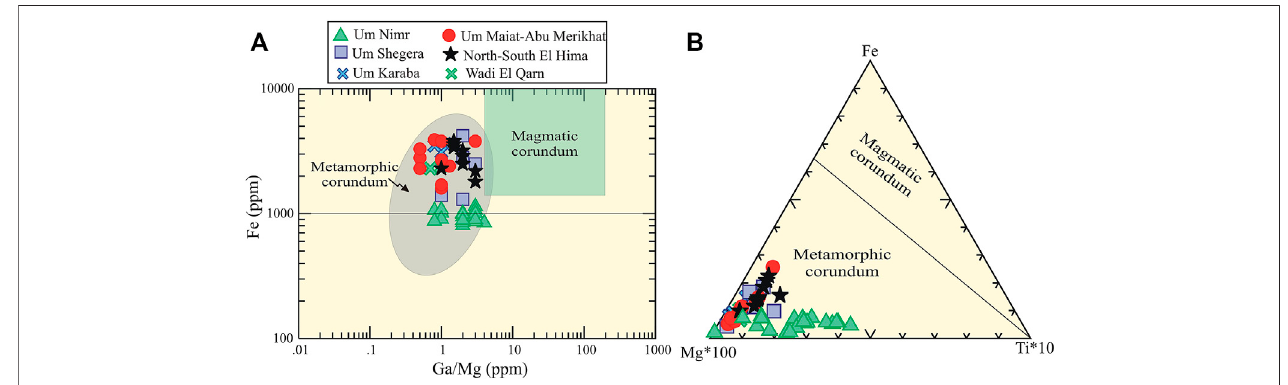
FIGURE 14 | (A) Fe versus Ga/Mg (ppm) and (B) Mg-Fe-Ti (ppm) diagrams of the examined corundum. Fields of metamorphic and magmatic are obtained from Peucat et al. (2007).